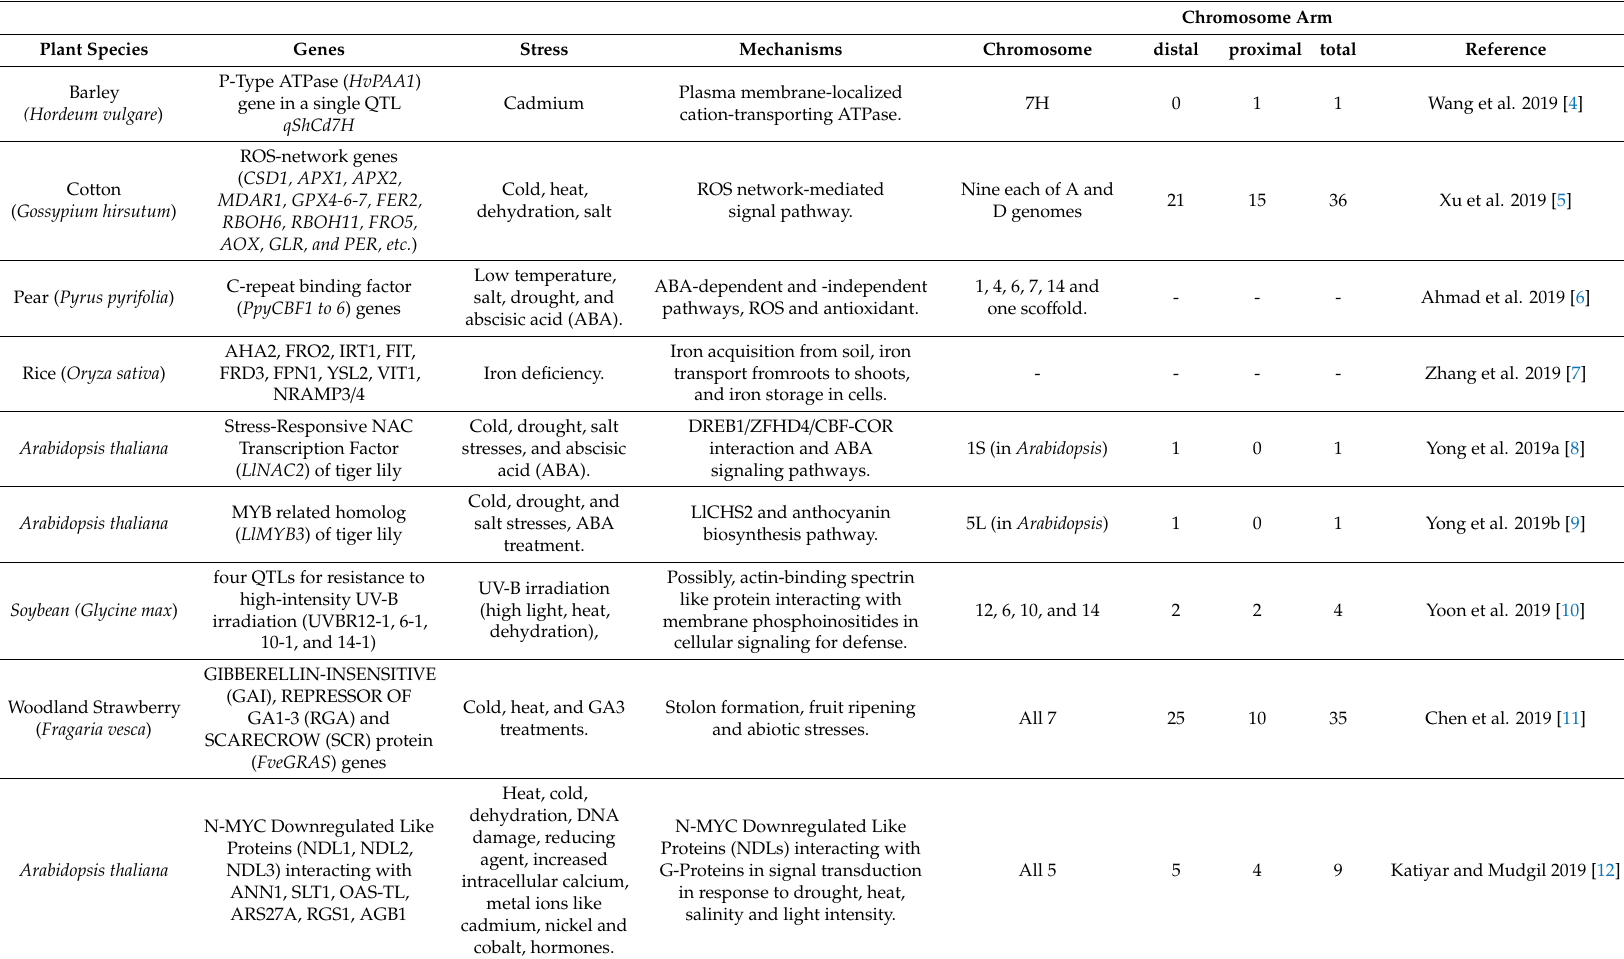
Table 1. Chromosomal distribution of genes controlling tolerance to abiotic stresses.